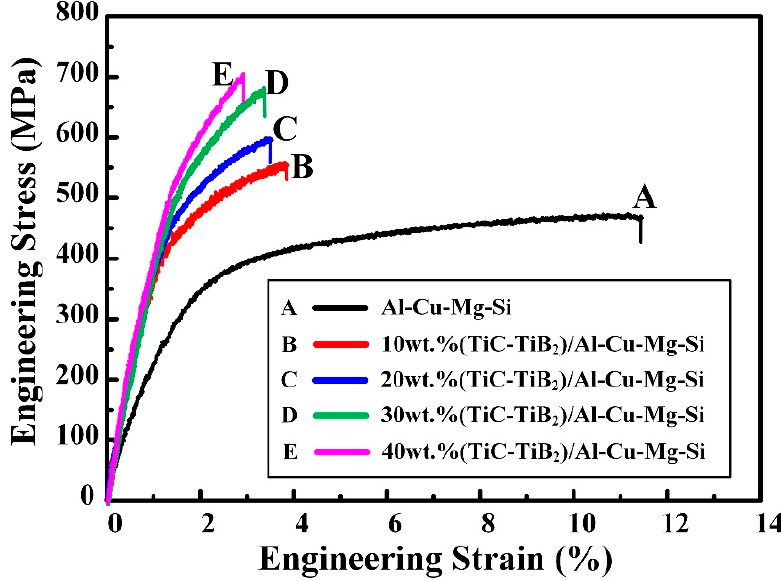
7 of 16 Figure 5. ( a ) SEM image, ( b ) inverse pole figure (IPF) image and ( c ) recrystallized microstructure EBSD image of the extruded 10 wt.% (TiC-TiB 2 )/Al-4.7Cu-0.32Mg-0.44Si composite after T6 heat treatment.